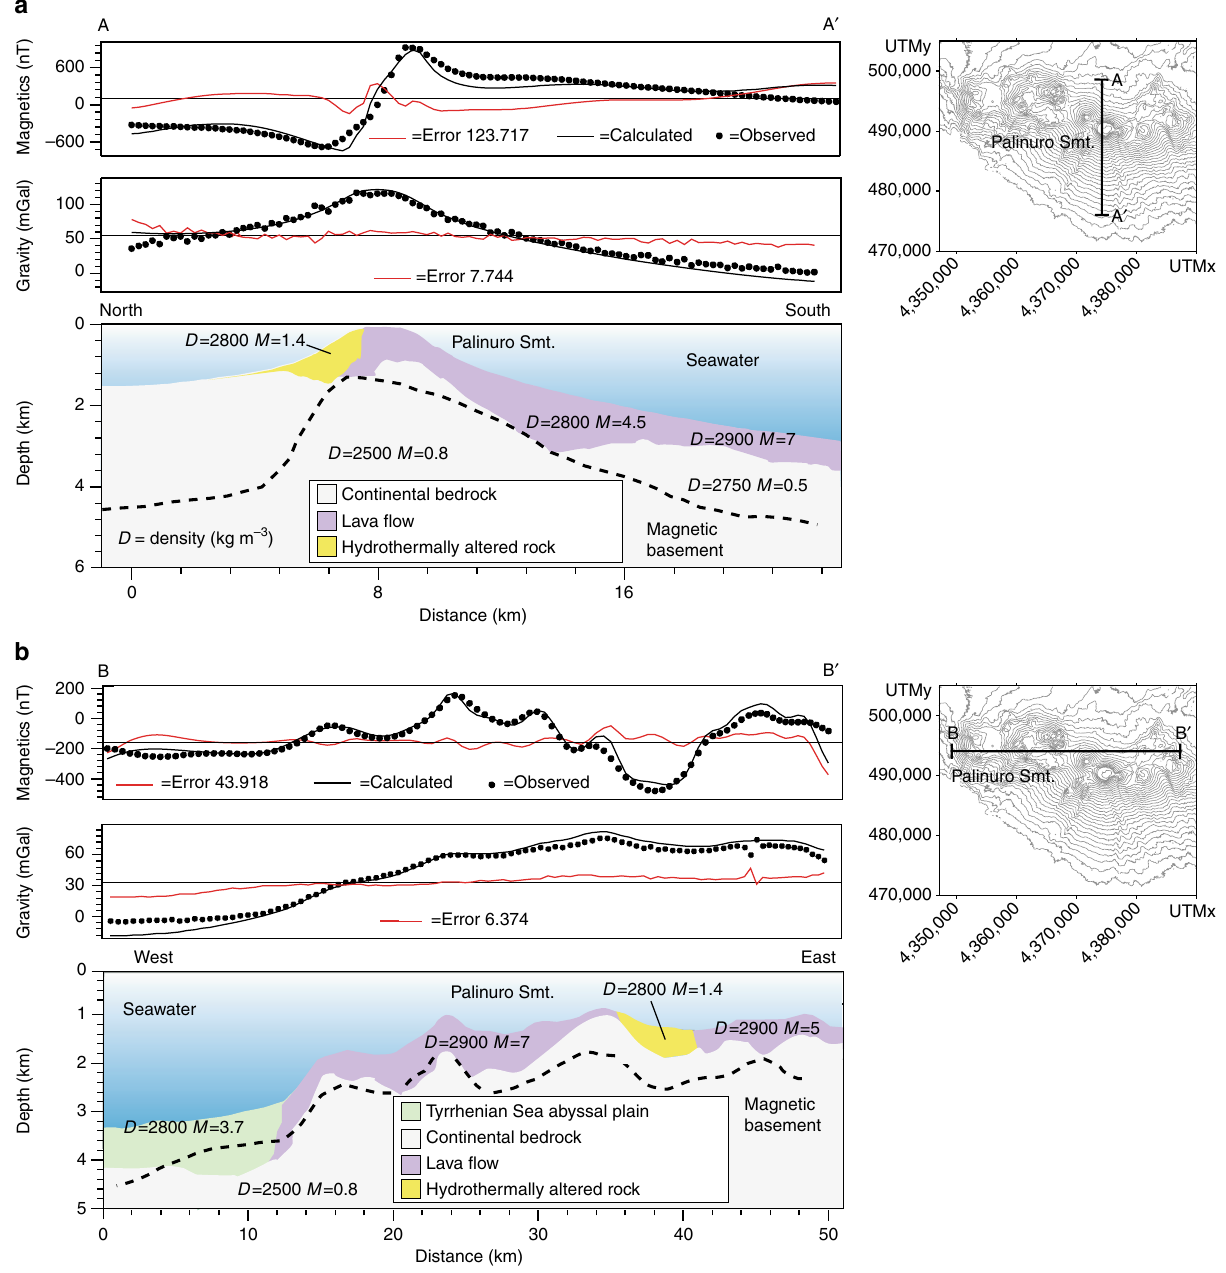
Fig. 8 Results of the 2.5D magnetic and gravity forward models of the central sector of the Palinuro Seamount and surrounding volcanoes. a A – A ′ is a N-S pro fi le crossing the summit cone. b B – B ′ is an E-W pro fi le intercepting a caldera-like depression; the location of the pro fi les are reported in the insets. The dashed line represents the lower bound of the magnetized crustal portion by derivative computation. The dimensioning of the different bodies was estimated point by point as function of the effective distribution of sea fl oor features and are constrained by interpreted seismic lines 27,